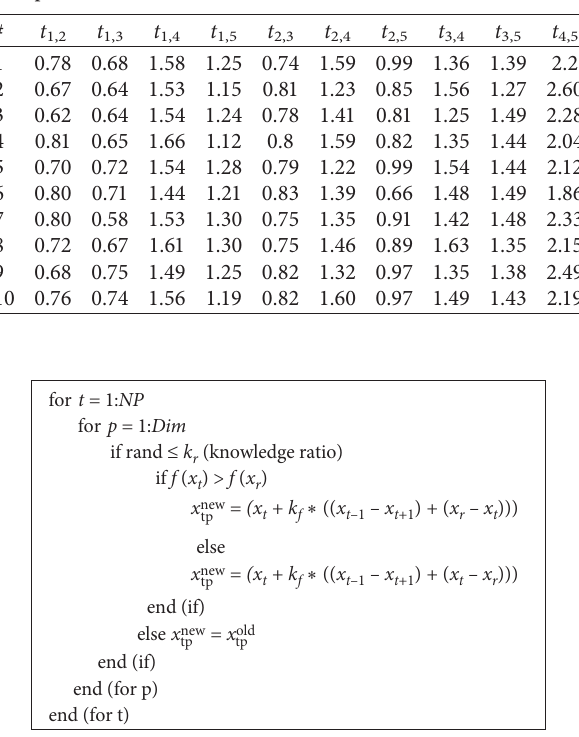
Figure 5: Pseudocode for junior gaining-sharing knowledge stage. Note: k f ( > 0 ) is the knowledge factor.